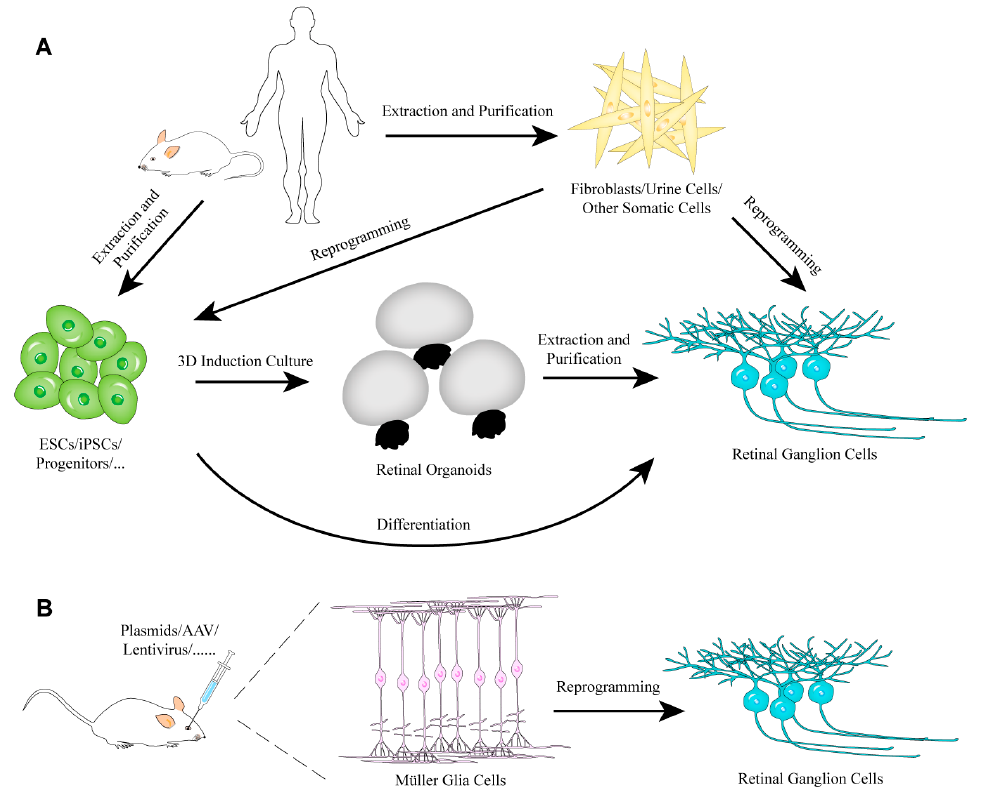
Figure 1. The strategies of RGC regeneration in vitro ( A ) or in vivo ( B ). Table 1. Published retinal ganglion cell induction or regeneration protocols.